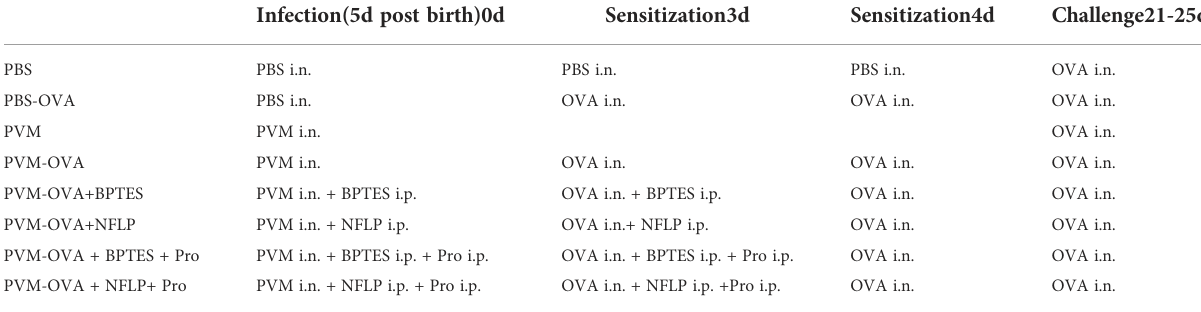
TABLE 1 Animal sensitization and challenge